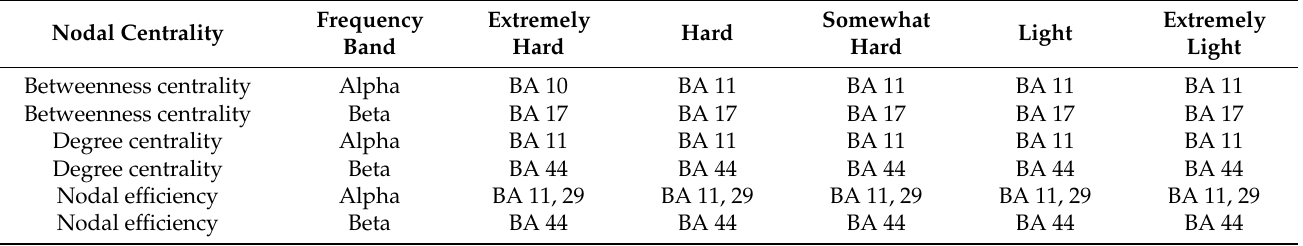
Table 10. Summary of the highest nodal centrality for the alpha and beta networks for each exer- tion